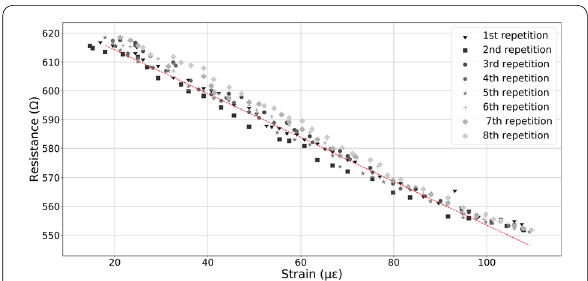
Fig. 10 Piezoresistive phenomenon characterization for sample with 0.8 % wt of